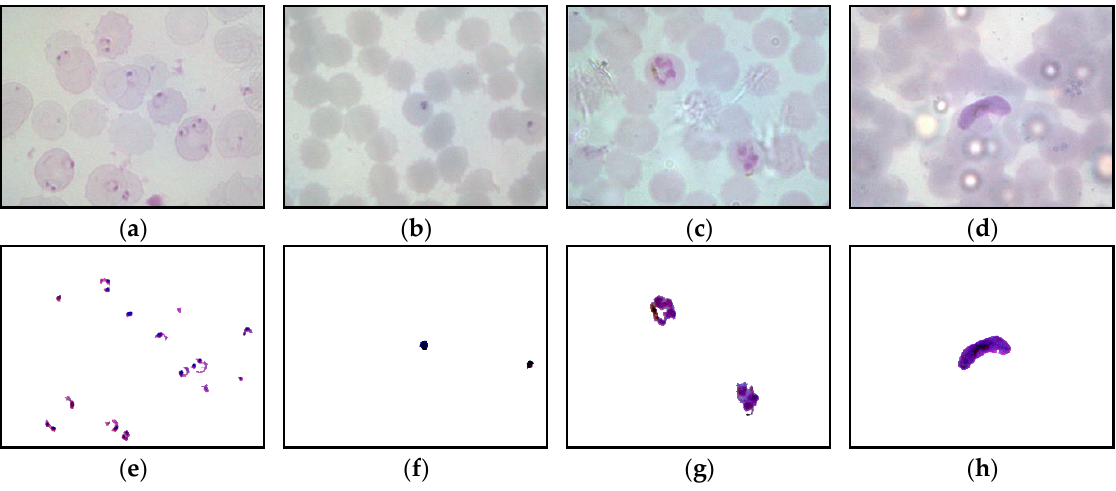
Figure 8. Original and final segmented images for P. falciparum : ( a ) Original ring; ( b ) Original trophozoite; ( c ) Original schizont; ( d ) Original gametocyte; ( e ) Segmented ring ( f ) Segmented trophozoite; ( g ) Segmented schizont; ( h ) Segmented gametocyte.